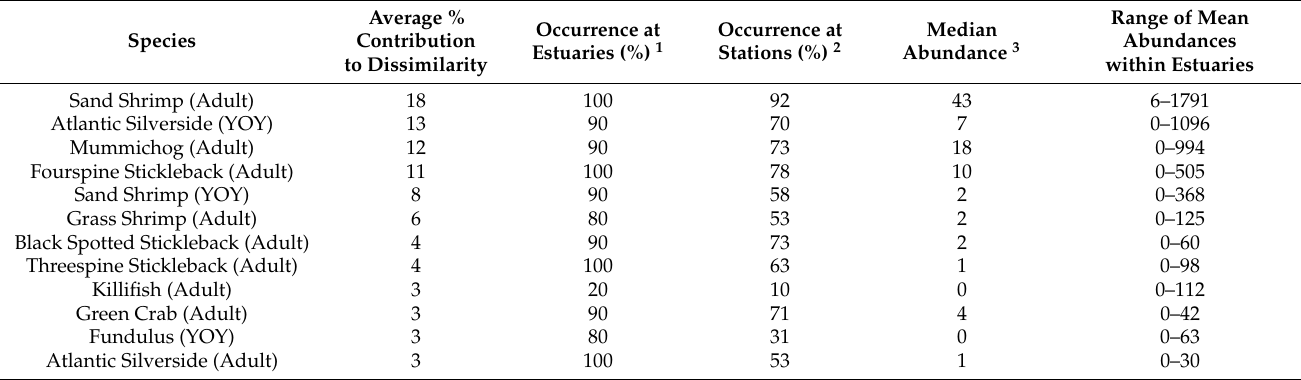
Table 6. Results of the similarity percentages routine (SIMPER) measuring the contribution of each species to the dissim- ilarities between estuaries as defined by the Bray–Curtis dissimilarity between each pair of estuaries based on nekton data collected from the Community Aquatic Monitoring Program (CAMP) stations. In addition, the occurrence, median abundance, and range of average abundances within estuaries for each